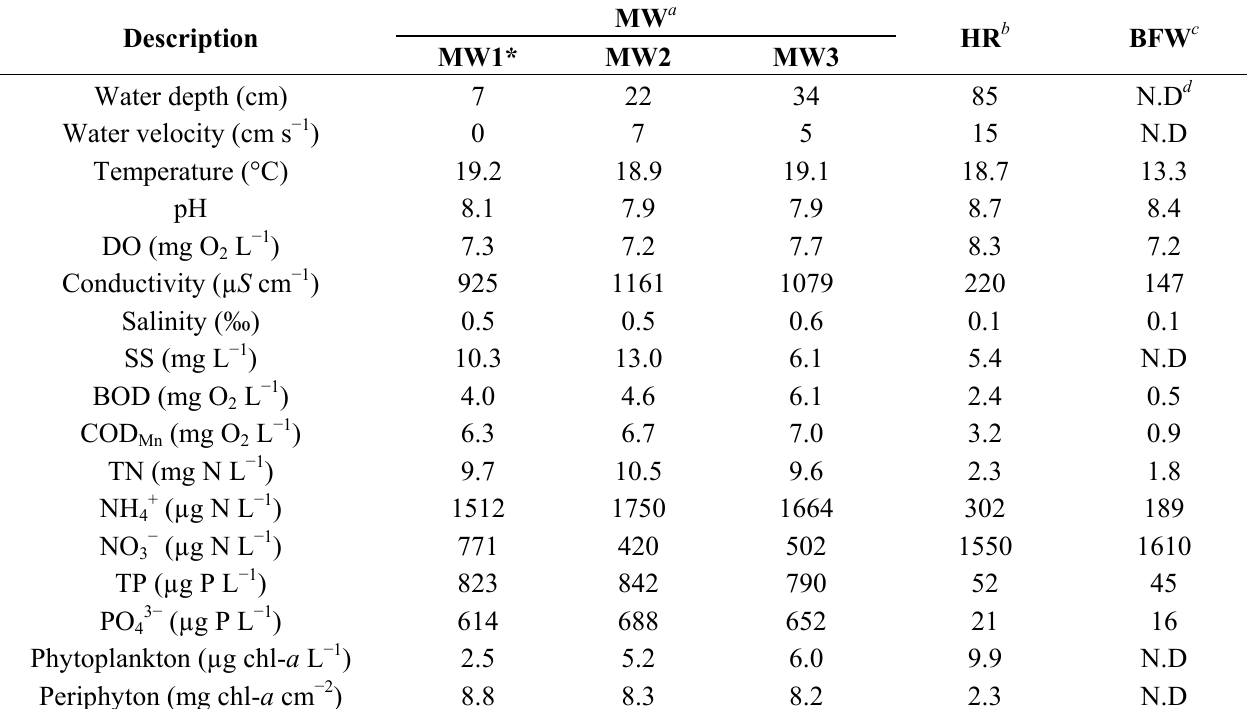
Table 2. Summary of water quality analysis results for three water sources sampled in April 2010 (n =